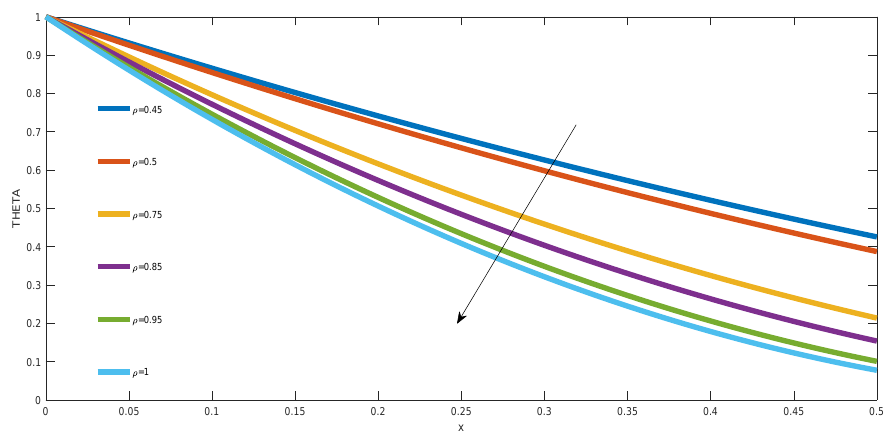
Figure 1. Solution of Equation (12) for θ versus x when ϕ = 1 and ρ ≤ 1.